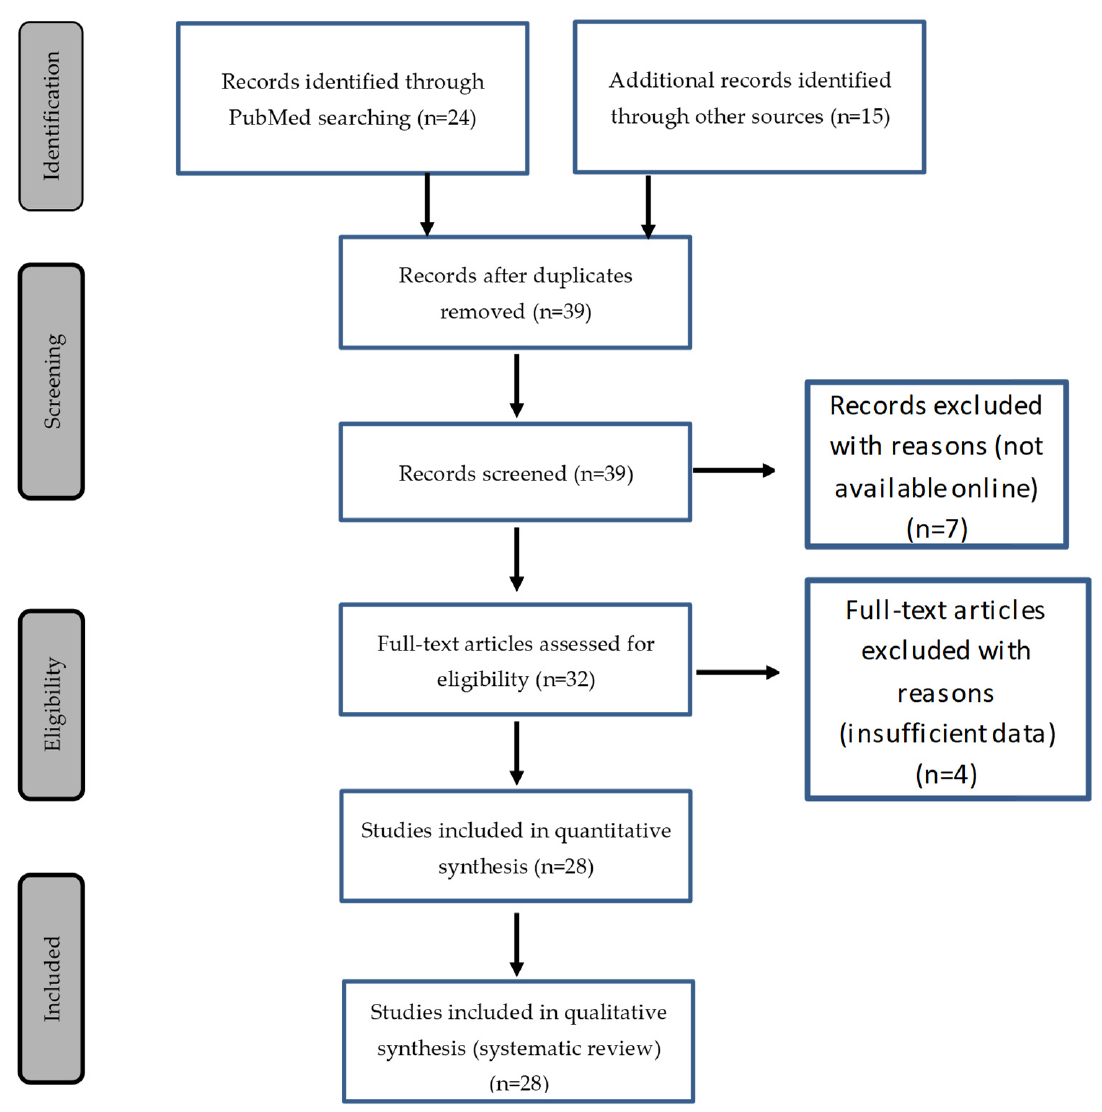
Figure 1. PRISMA (Preferred Reporting Items for Systematic Reviews and Meta-Analyses) flow diagram of the study